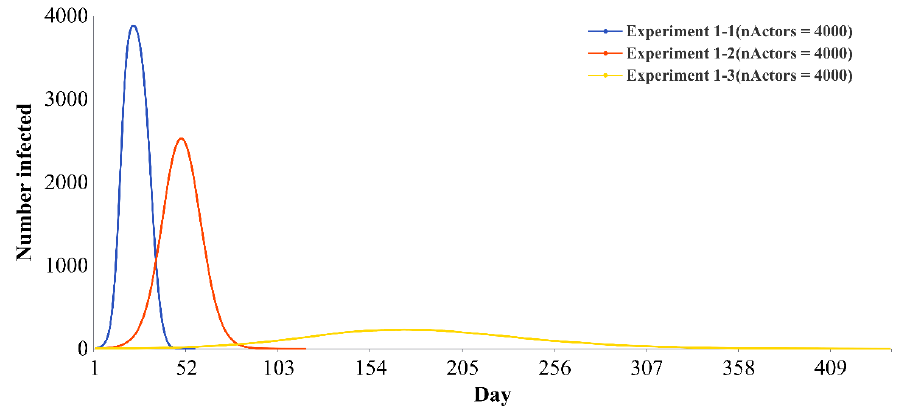
Figure 7. Infection curves of the basic experiments with 4000 individuals.